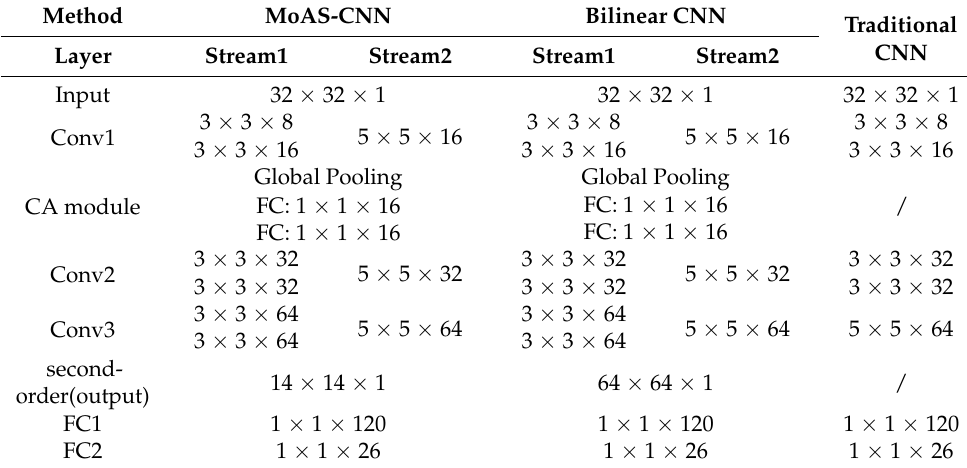
Figure 6. The dataset of 26 letter-shape samples ( A – Z ). Table 1. Detailed parameters of CNNs.